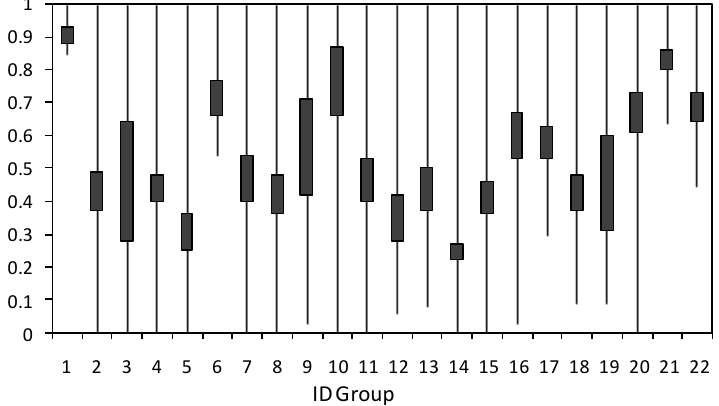
Figure 2. Average group association index (AI). The figure shows the AI average value, ± the standard error (dark square blocks), and the maximum and minimum values in the 22 competitive groups evaluated.